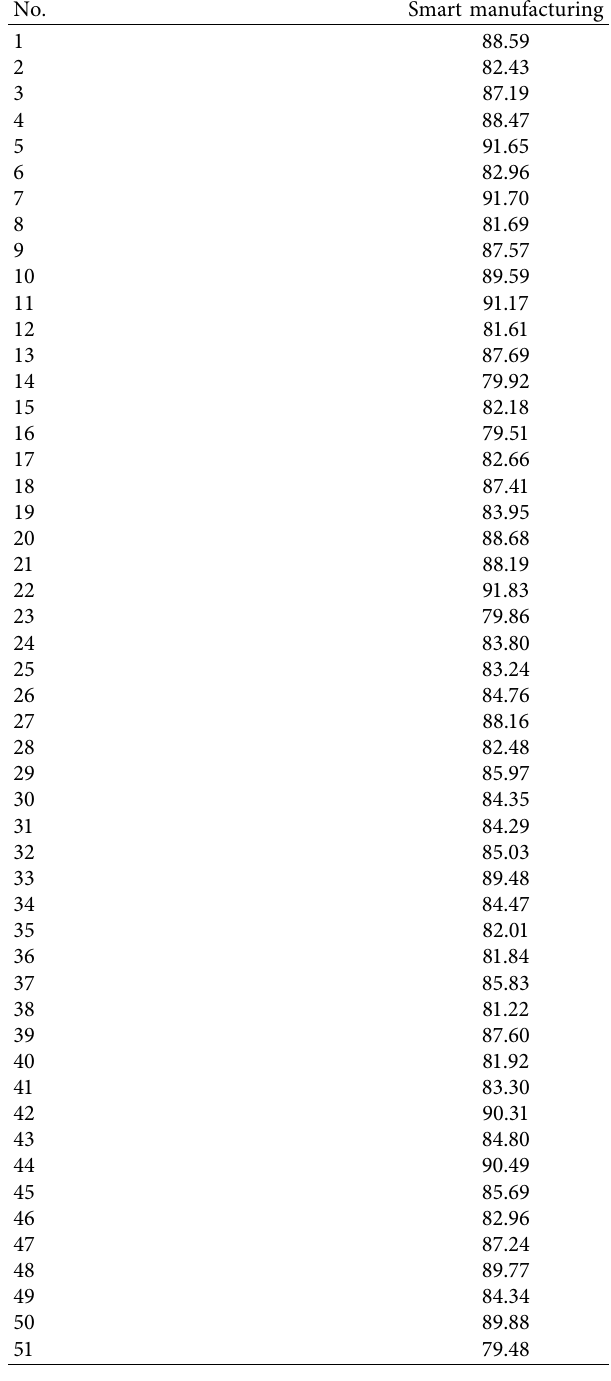
Table 2: Effectiveness of intelligent manufacturing